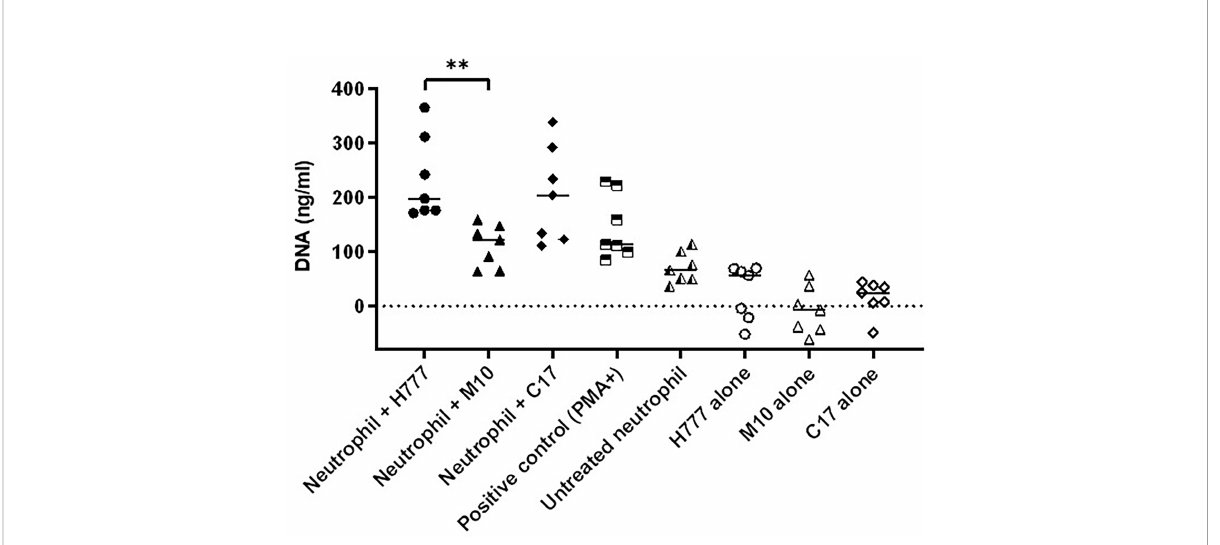
FIGURE 4 B. pseudomallei H777 ( bpsl0618 wild type) and C17 ( bpsl0618 complemented) induced greater release of extracellular DNA from neutrophils than did M10 ( bpsl0618 defect mutant). Neutrophils were stimulated with either B. pseudomallei at the MOI of 10 or 50 nM PMA followed by MNase treatment in supernatant. The DNA was quanti fi ed in 3 independent experiments (n = 7). Data are represented as mean ± standard deviation. Asterisks denote statistical signi fi cance (** p <